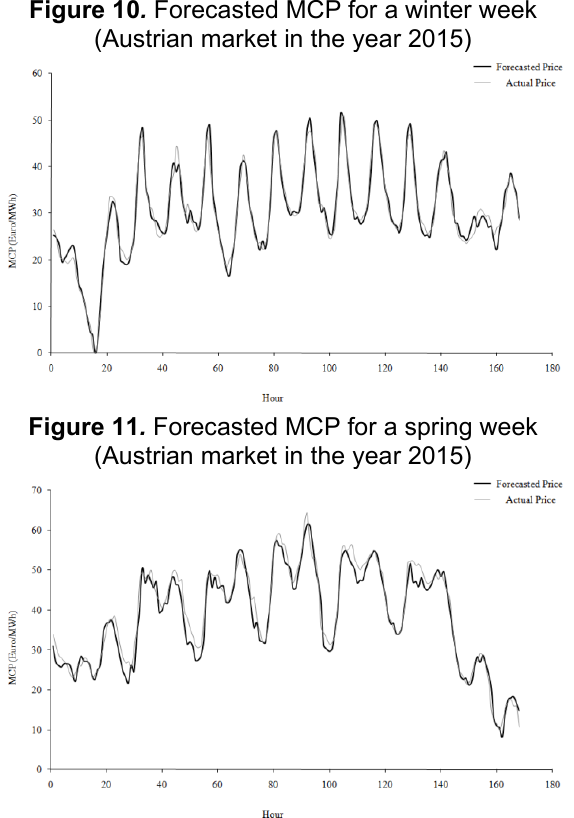
Figure 12 . Forecasted MCP for a summer week (Austrian market in the year 2015)